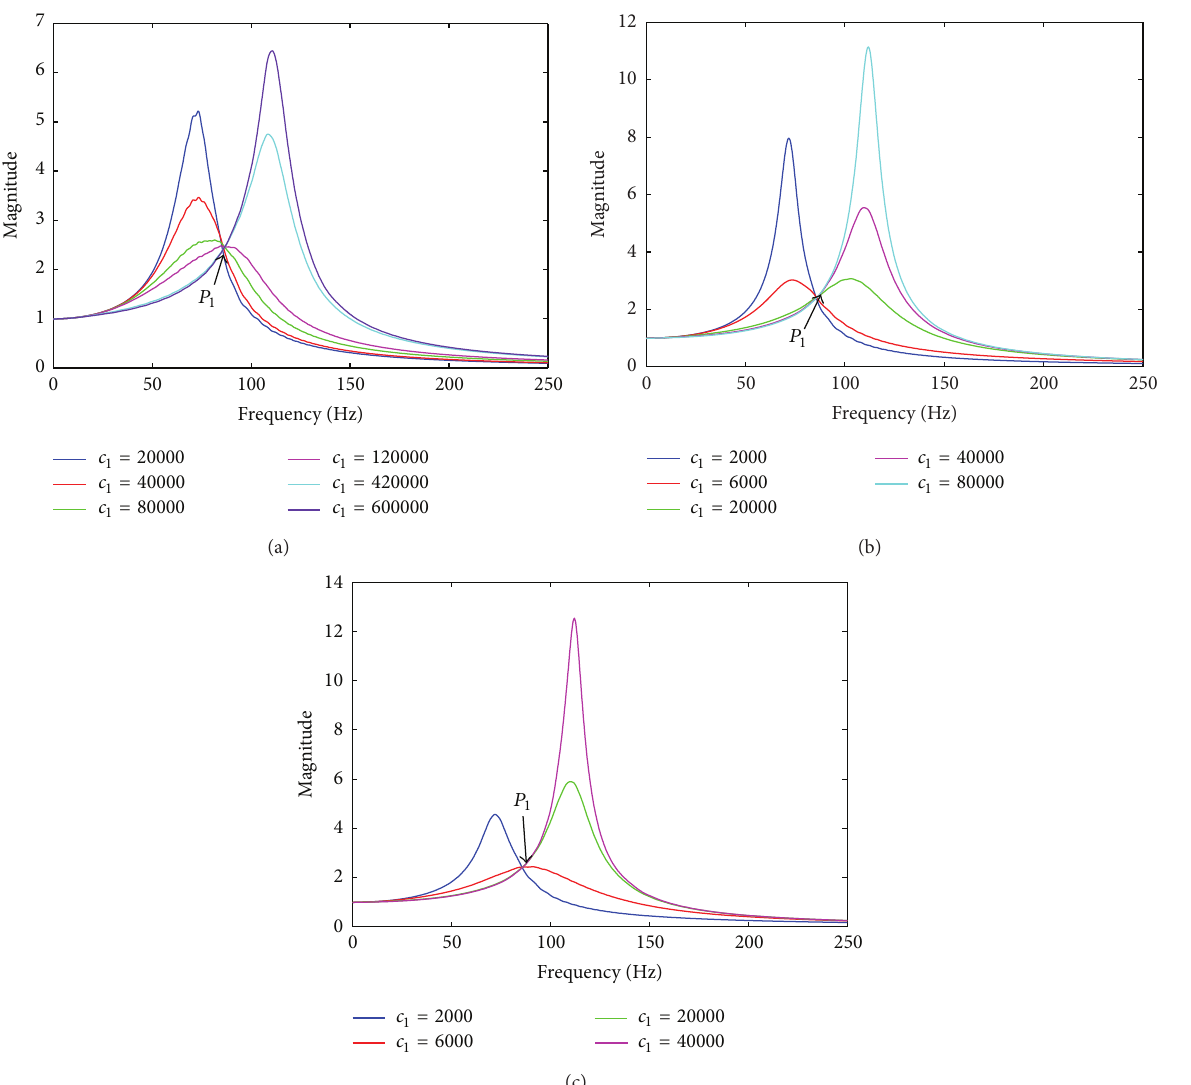
Figure 13: Force transmissibility curves of GNM under 100N FE cases. (a) 𝑛 1 = 1.5 ; (b) 𝑛 1 = 1 Maxwell model; (c) 𝑛 1 = 0.85